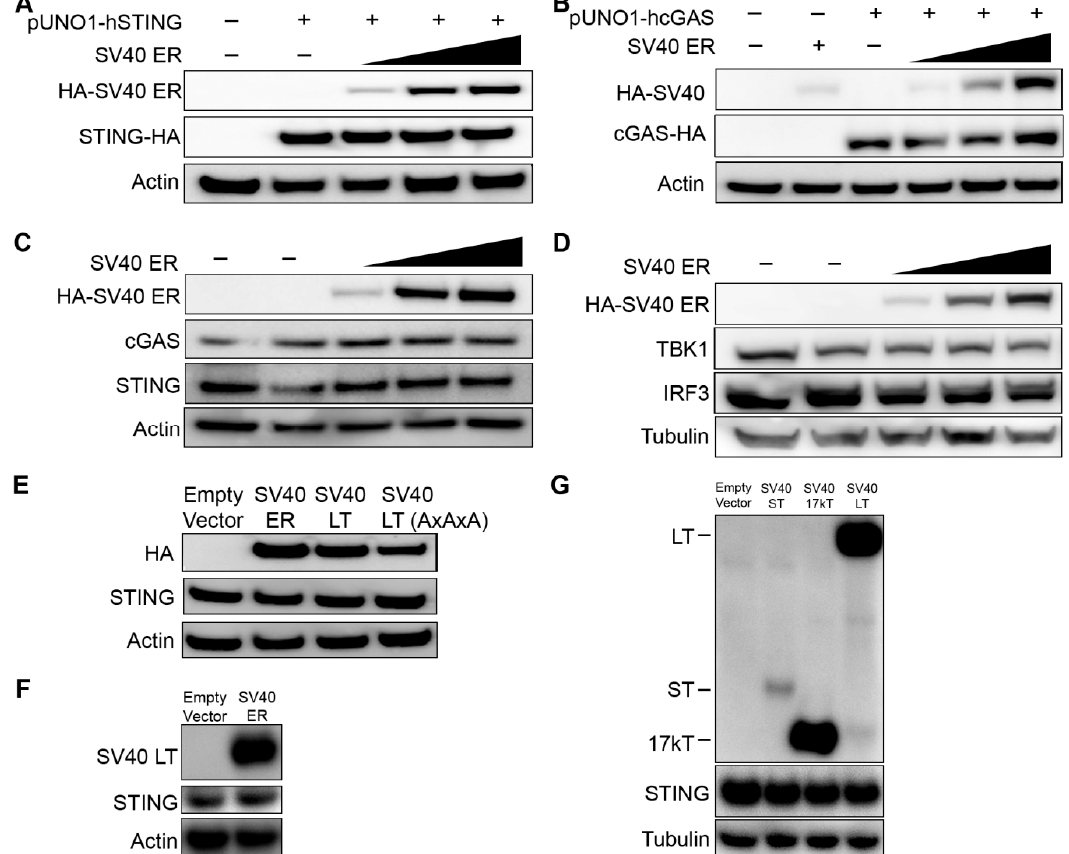
Figure 2. The effect of SV40 early region on exogenous and endogenous cGAS and STING expression. ( A ) The 293T cells were co ‐ transfected with 100 ng of hemagglutinin (HA) epitope ‐ tagged human STING (pUNO1 ‐ hSTING ‐ HA3x) with increasing amounts of SV40 early region (ER) plasmid (100 ng, 500 ng, and 1 μ g). The anti ‐ HA antibody was used for the detection of SV40 ER and STING. Actin or Tubulin was probed as a loading control as indicated. ( B ) The 293T cells were co ‐ transfected with 100 ng of HA epitope ‐ tagged human cGAS (pUNO1 ‐ hcGAS ‐ HA3x) with increasing amounts of SV40 ER plasmid (100 ng, 500 ng, and 1 μ g). ( C , D ) 293 cells were transfected with the same increasing amounts of SV40 ER plasmid (100 ng, 500 ng, and 1 μ g). Western blot analysis for endogenous levels of (C) cGAS and STING, and (D) TANK ‐ binding kinase 1 (TBK1) and interferon regulatory factor 3 (IRF3) was assessed. ( E ) The 293 cells were transfected with 500 ng of SV40 ER, SV40 large T antigen (LT), or SV40 LT AxAxA (mutations in the LxCxE motif). The endogenous expression of STING was assessed by western blot analysis. ( F ) The 293 cells were co ‐ transfected with 1 μ g of empty vector or untagged SV40 ER. The figure shows western blot analyses for SV40 LT with a monoclonal SV40 T ‐ antigen antibody, endogenous STING, and Actin (loading control). ( G ) The 293 cells were transfected with 1 μ g of SV40 ST, 17kT, or LT plasmid. Western blot analysis was performed at 24 hours post ‐ transfection for endogenous STING expression, HA epitope ‐ tagged SV40 ST, 17kT or LT, and Tubulin